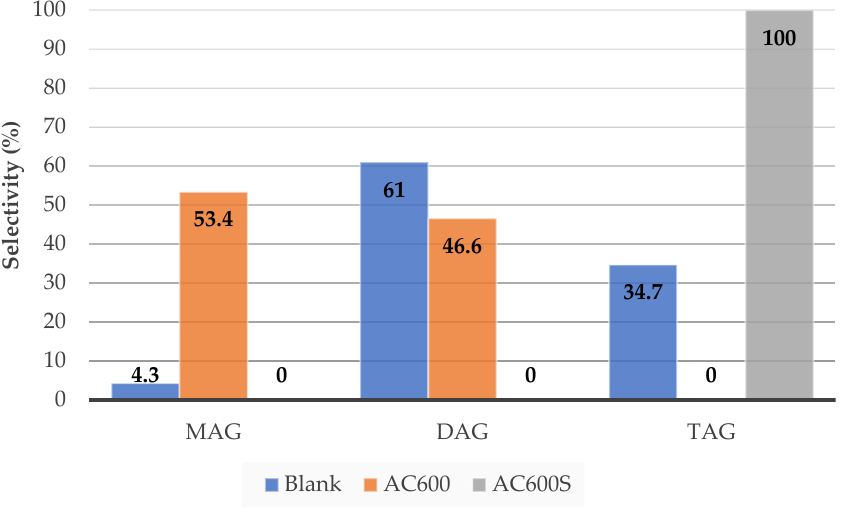
Figure 5. Influence of catalyst on product selectivity at 100 mol % conversion for reaction conditions: ~5 wt% catalyst, T = 100 C; glycerol:Ac 2 O (molar ratio) = 1:5, no stirring, and 50 min reaction time for AC600 and AC600S catalysts and 180 min for the blank experiment [55].